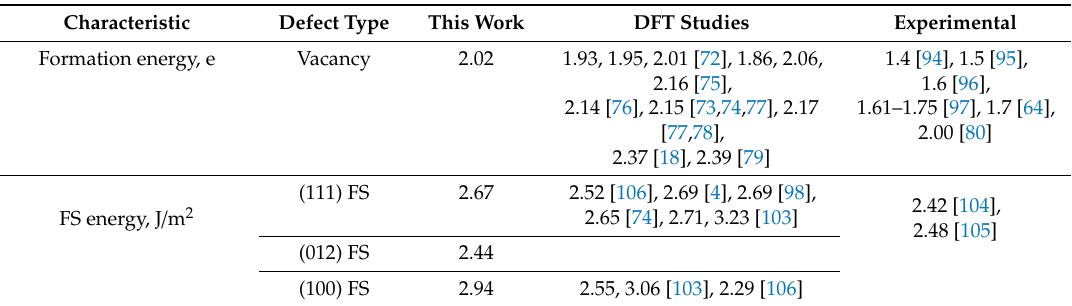
Table 2. Formation energies of a vacancy; ½<111> screw and (b) M111 mixed dislocations; (111), (100) and (012) FS; Σ 3 (111) [1–10], Σ 5 (100) [100] and Σ 5 (012) [100] GBs and the corresponding W sep of bcc